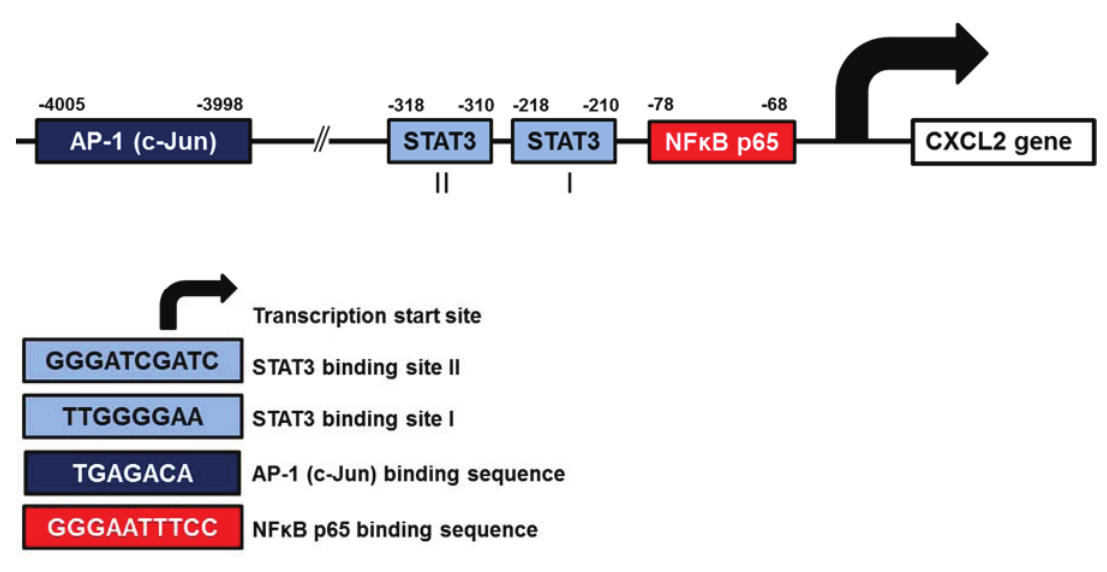
Figure 3. Schematic illustration of human CXCL2